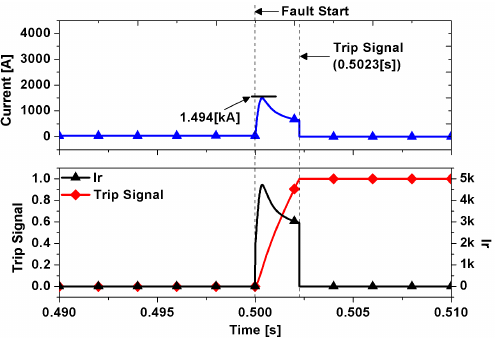
Figure 7. Fault Current and Trip Signal when using the voltage component of high temperature superconductivity (HTSC)